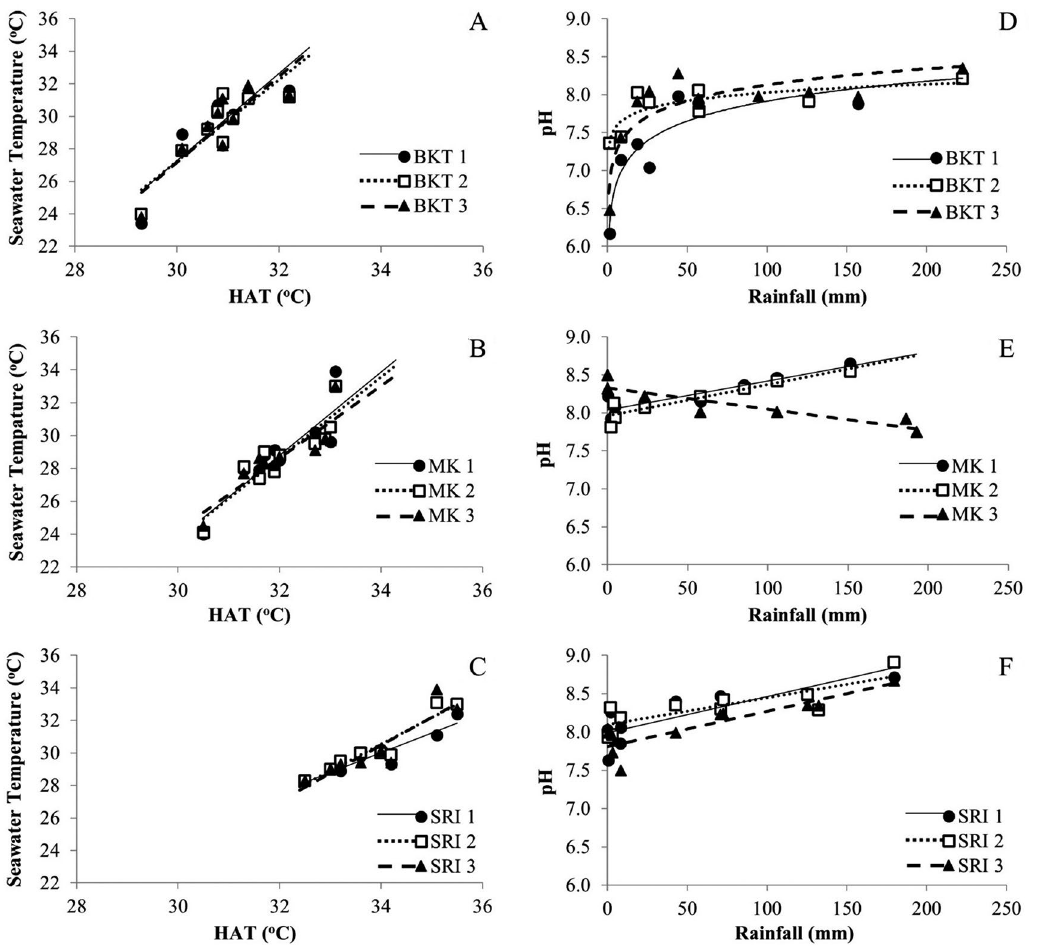
Fig. 2. – Correlation between the average of the highest air temperature (HAT) and seawater temperature (A, B and C), and correlation between rainfall and pH of seawater (D, E, and F) at each sampling station in the pond area of Bangkhuntein (BKT), the estuary area of the Maeklong river mouth (MK) and the coastal area of Sriracha (SRI) based on monthly measurements from January to December